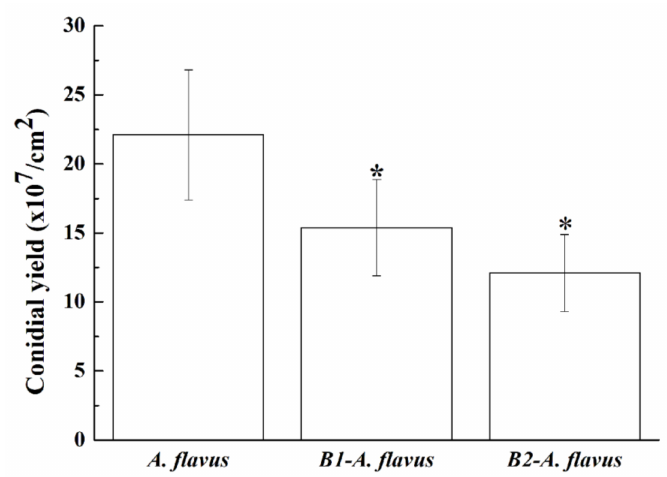
Figure 3. Conidial yields (mean ± SE) of A. flavus and A. flavus antagonized by B1 and B2. Conidial yields were determined at 10 days post-inoculation. The star (*) indicates that A. flavus inhibited by B1 and B2 both produce significantly less conidia than the control ( p < 0.05).